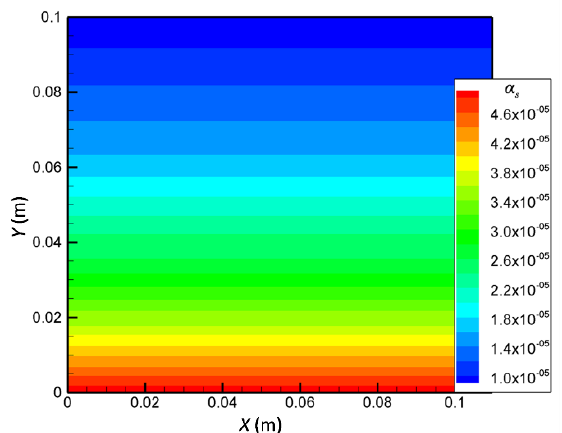
Figure 2. Spatial distribution of the sand concentration on the X – Y plane at u ∗ = 0.395 m / s and d s = 250 µ m.